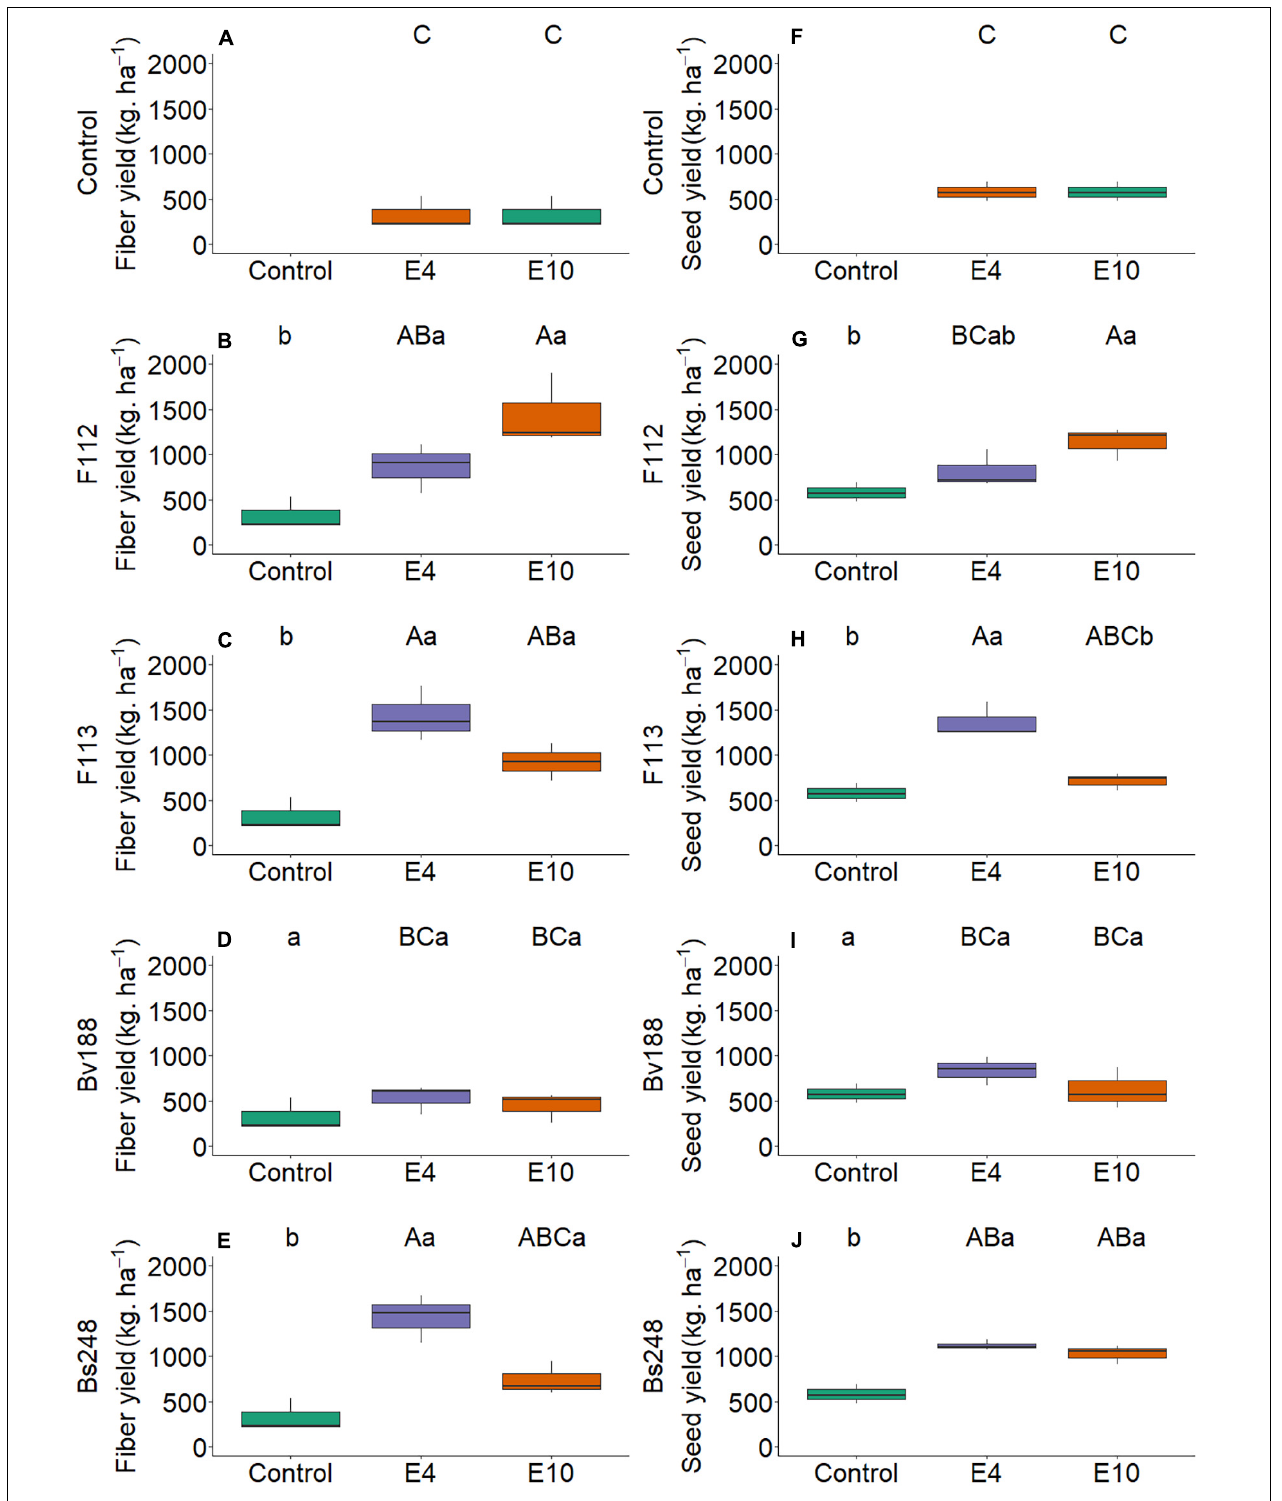
FIGURE 11 | Boxplots (median and quartiles) of fiber (A–E) and seed (F–J) cotton yield inoculated with plant growth-promoting microorganisms in two concentrations. Different lowercase letters in a row and uppercase letters in a column indicate statistical difference between means (Tukey, p < 0.05). F112, Aspergillus sydowii ; F113, Aspergillus sp.; Bv188, Bacillus velezensis strain Bv188; Bs248, Bacillus subtilis strain Bs248; E4, 1 × 10 4 ; E10, 1 × 10 10 conidia or CFU mL − 1 ; Ctrl, control; and CFU, colony-forming units.